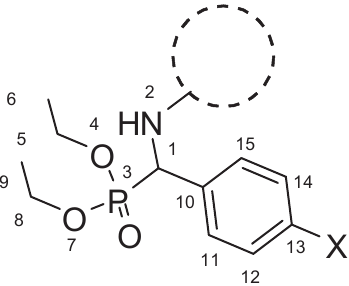
Figure 1: General structure of title compounds ( 7a-e and 8a-e